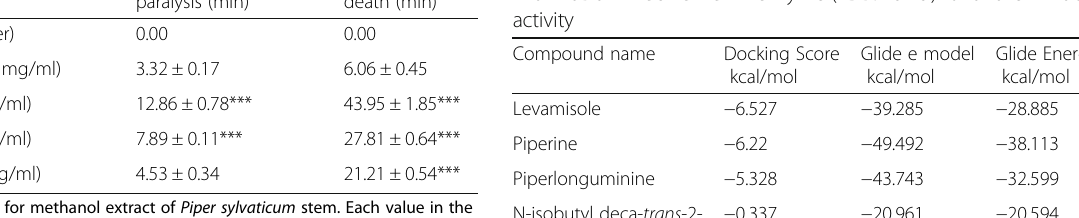
Table 1 Anthelmintic activity of methanol extract of Piper sylvaticum stem Treatment/Dose